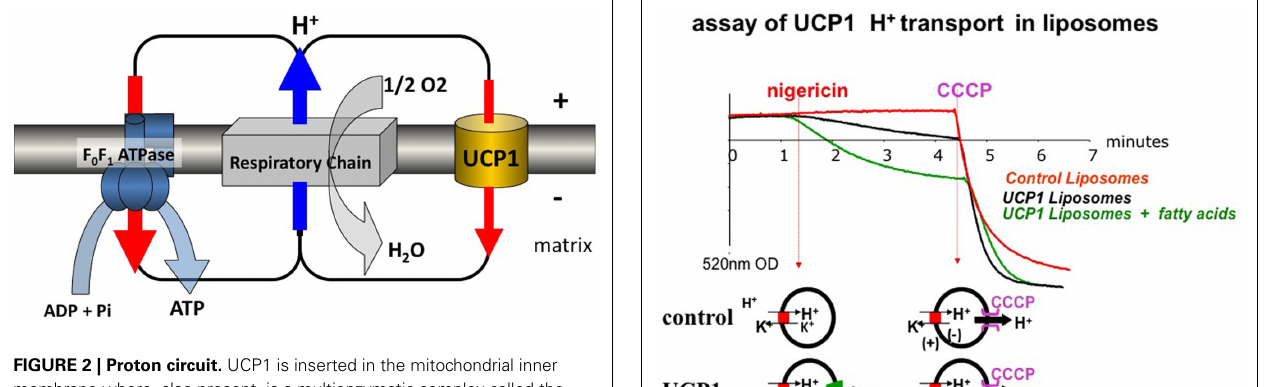
FIGURE 2 | Proton circuit. UCP1 is inserted in the mitochondrial inner membrane where, also present, is a multienzymatic complex called the respiratory chain made of complexes I to IV.The respiratory chain reoxidizes reduced coenzymes and electrons are driven to oxygen.This oxido-reduction step liberates energy which is used to generate an electrochemical gradient of protons across the inner membrane.This gradient is normally consumed by the ATP-synthase which phosphorylates ADP. UCP1 transports protons passively and makes possible a futile cycle of protons across the inner membrane leading to increased energy expenditure.This schema illustrates the situation encountered in brown adipocytes of mammals where a large amount of respiratory chains as well as a large amount of UCP1 are present. Activation of the futile cycling increases considerably energy expenditure and thus heat production by these thermogenic cells. In other cells where homologs of the UCP1 are expressed at much lower level, this pathway would represent a minor contributor to energy expenditure, but might be of importance to avoid